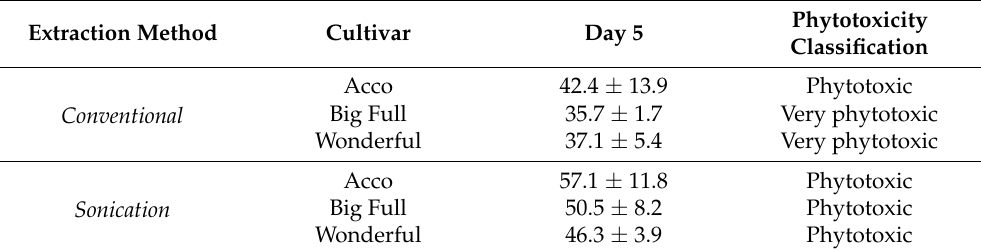
Table 10. Munoo-Liisa vitality index (%) for pomegranate peel extracts (0.003 g/mL) and phytotoxic- ity